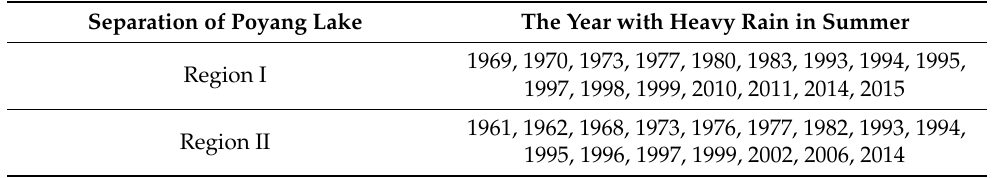
Table 1. Distribution of the rainy year of summer in different years of Poyang Lake.